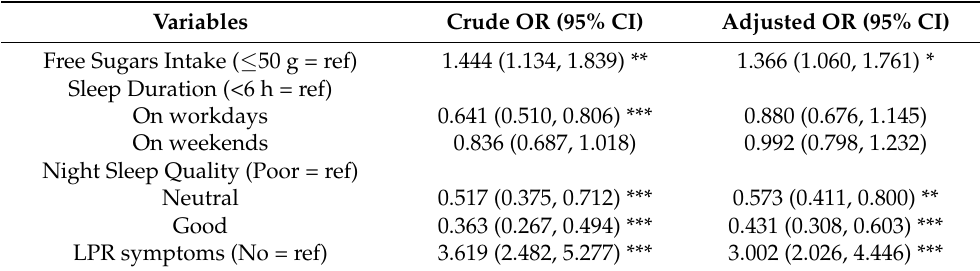
Table 3. Binary Logistic regression model of association between free sugars intake and EDS among adolescents (No EDS as the reference, n =